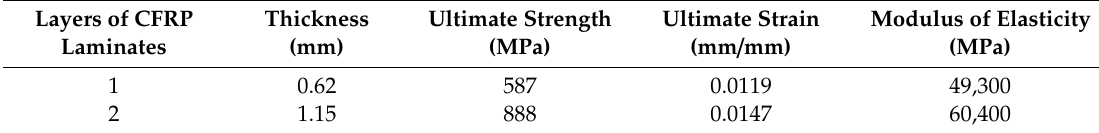
Table 2. Mechanical properties of the CFRP laminates.